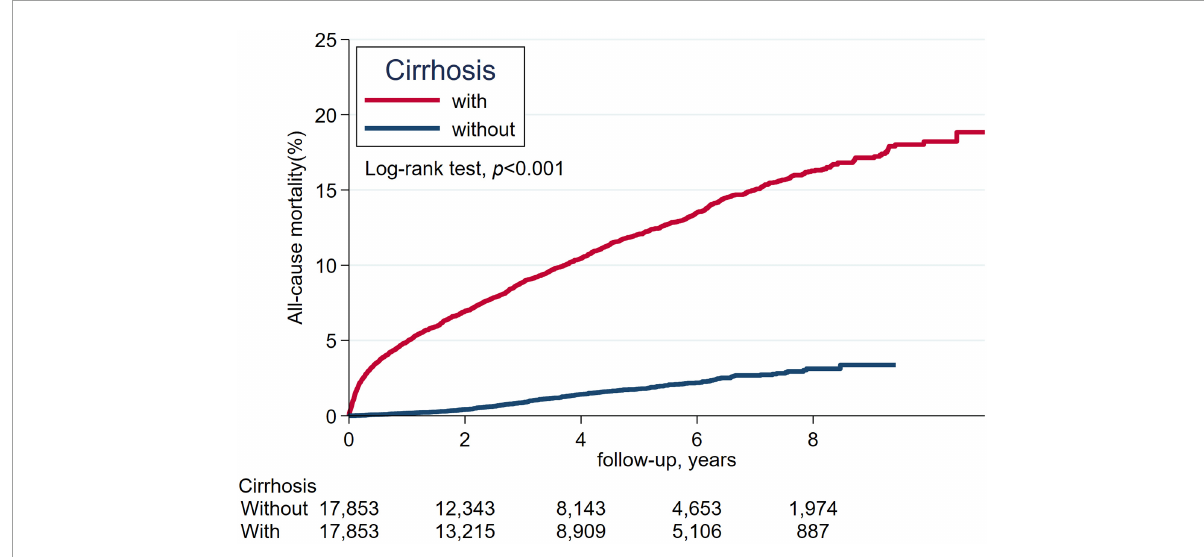
FIGURE2 The cumulative incidence of all-cause mortality between patients with cirrhosis and without cirrhosis.